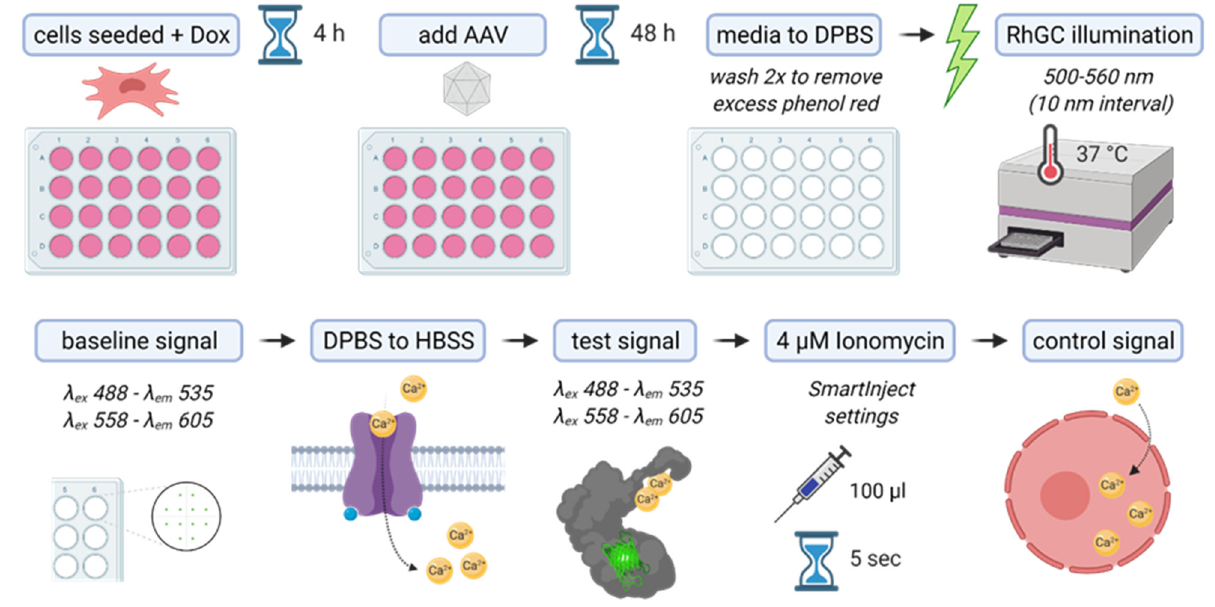
Figure 6. Illustration of the experimental design and set-up.